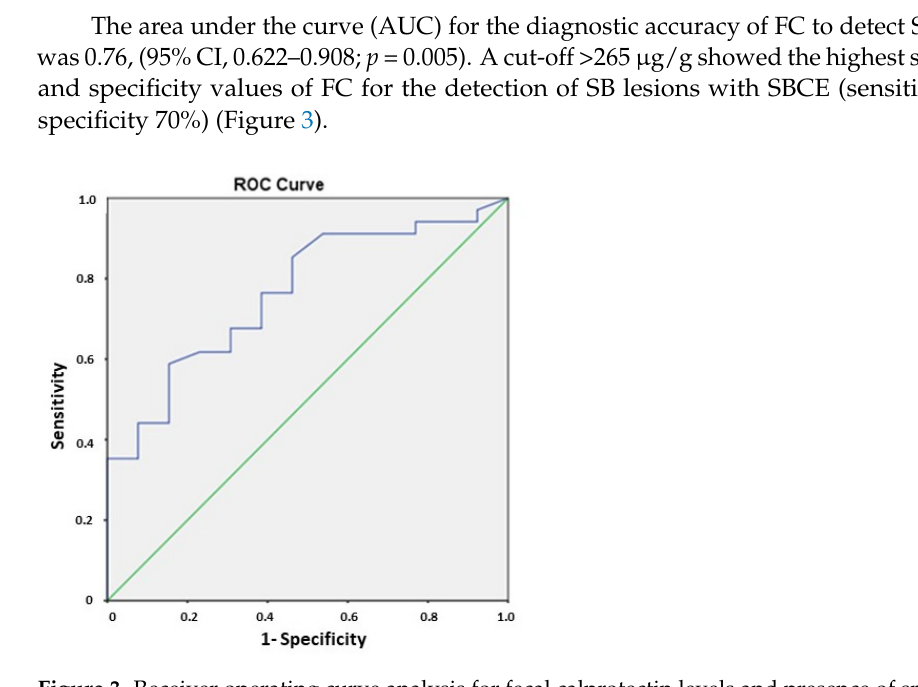
Figure 3. Receiver operating curve analysis for fecal calprotectin levels and presence of small bowel capsule endoscopy lesions.